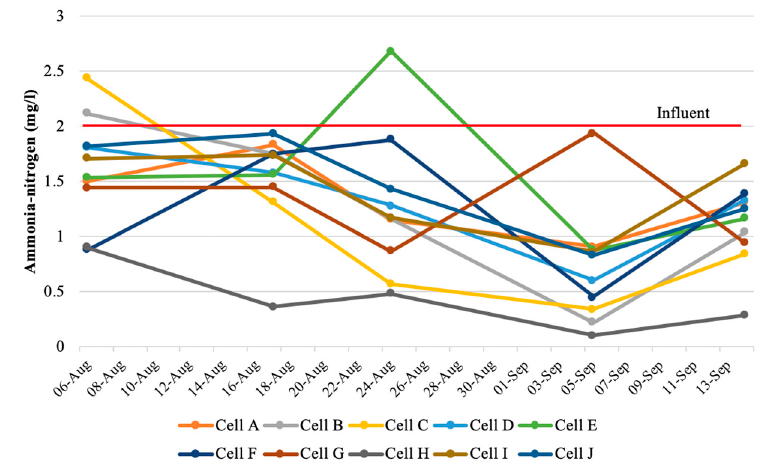
Figure 7. Variation in the ammonia-nitrogen concentrations with time.